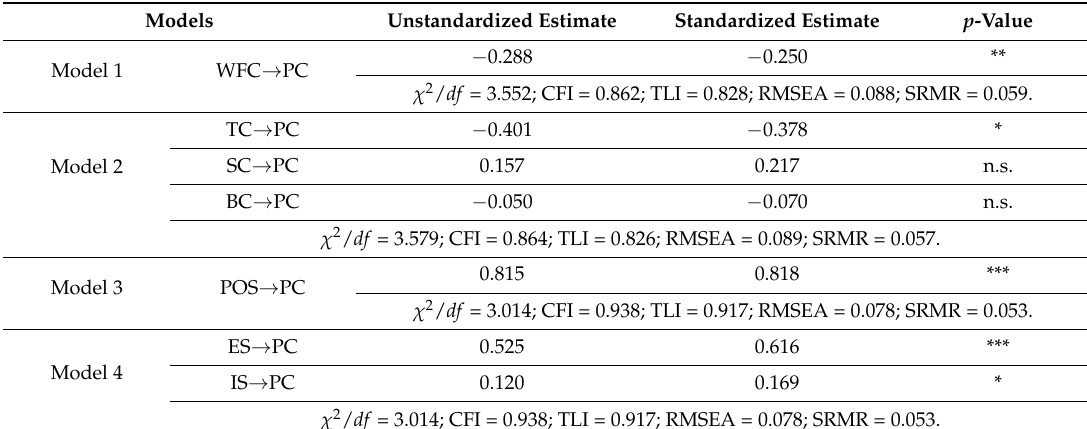
Table 7. The direct effects testing